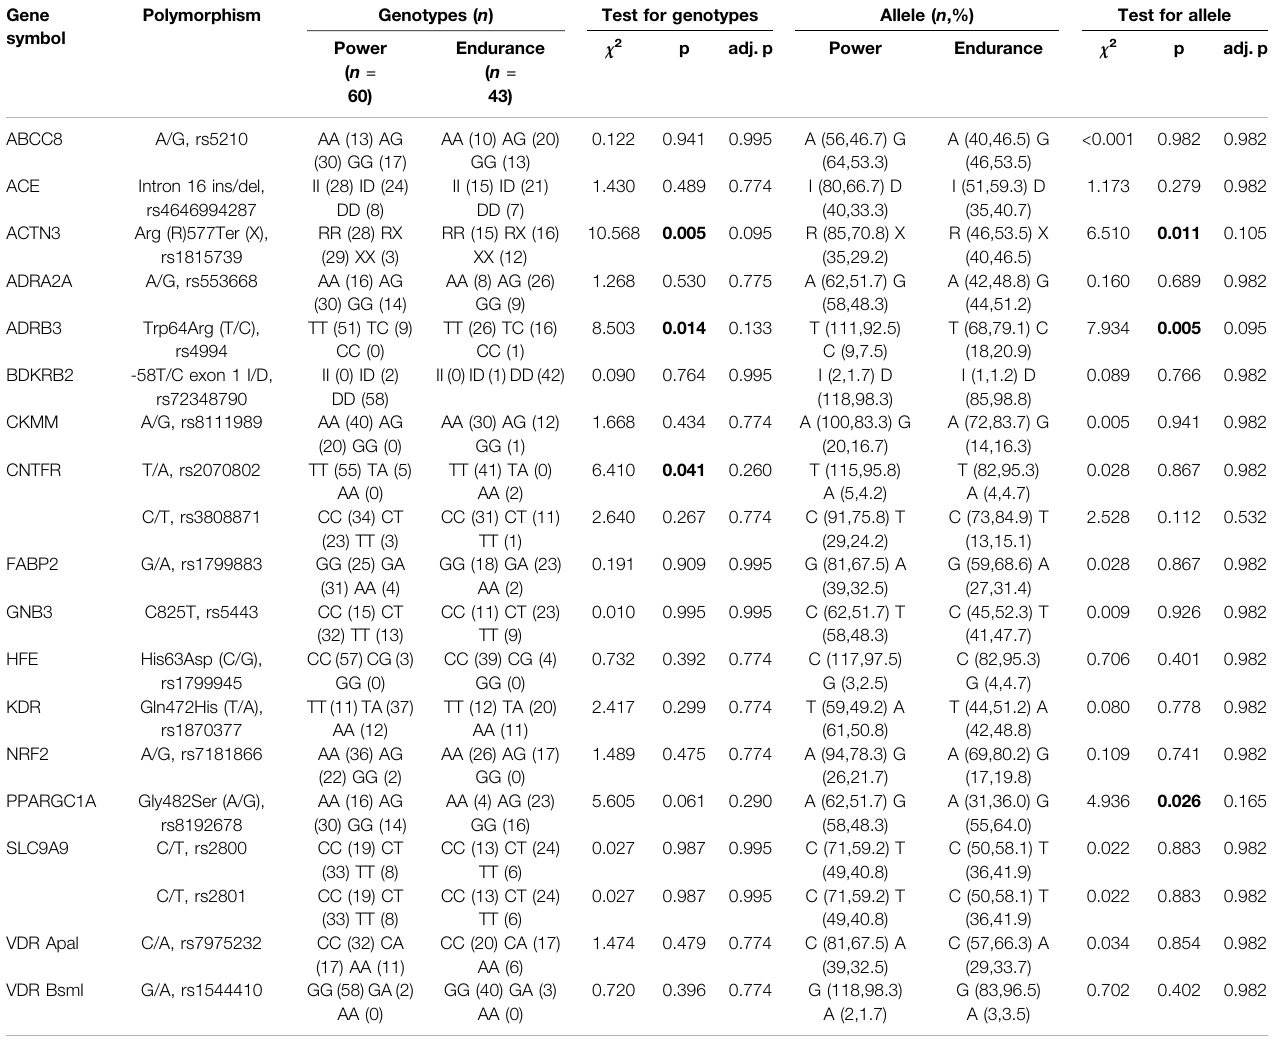
TABLE 1 | Genotypes and allele frequencies in Chinese elite power and endurance athletes. Gene symbol